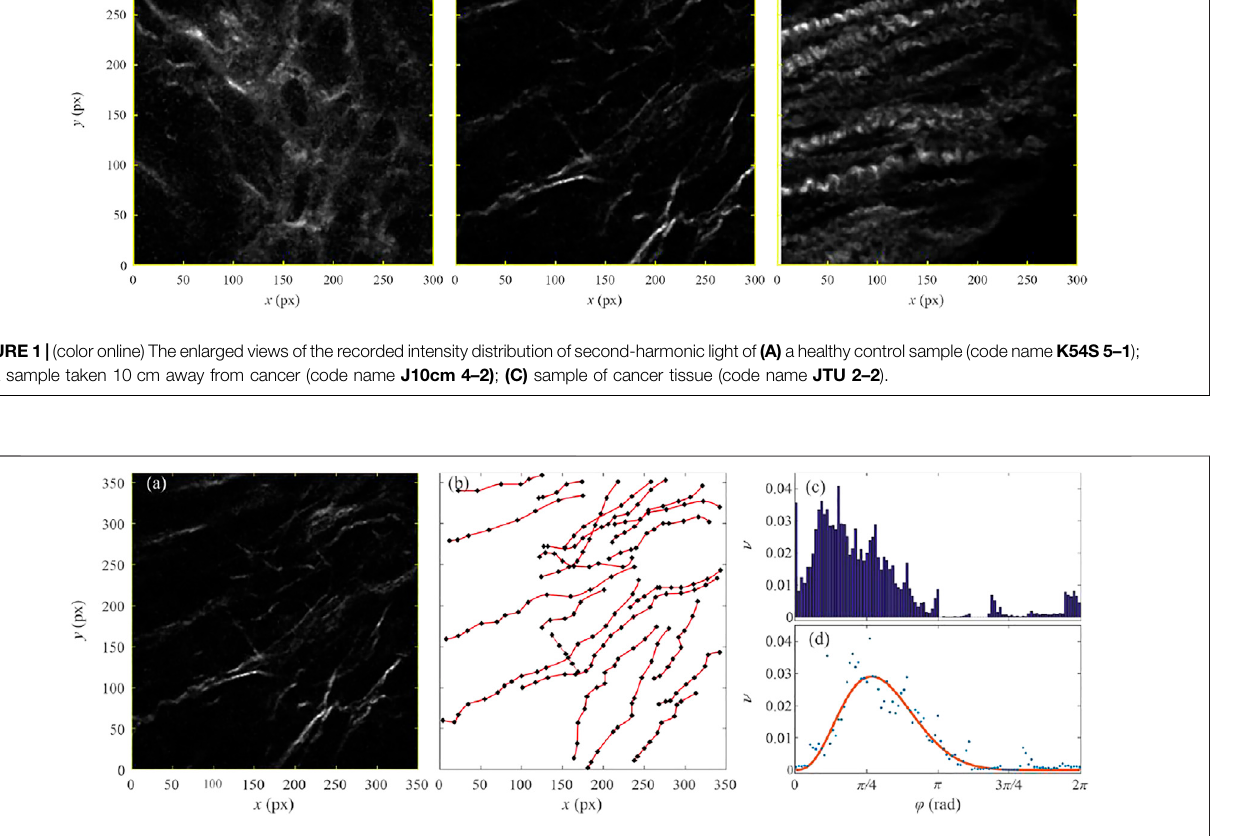
FIGURE 2 | (color online) (A) An image of the human colon mucosa 10 cm away from the tumor, code name J10cm 4-2 , recorded by the non-linear second harmonic microscopy. (B) Black squares show the characteristic points of the identi fi ed collagen fi bers. Red lines represent the cubic-spline fi t of the characteristic points. (C) A relative frequency of the angles between a small segment of the collagen fi ber and x axis. (D) The red line shows the optimal fi t of the relative frequencies (blue points) with the